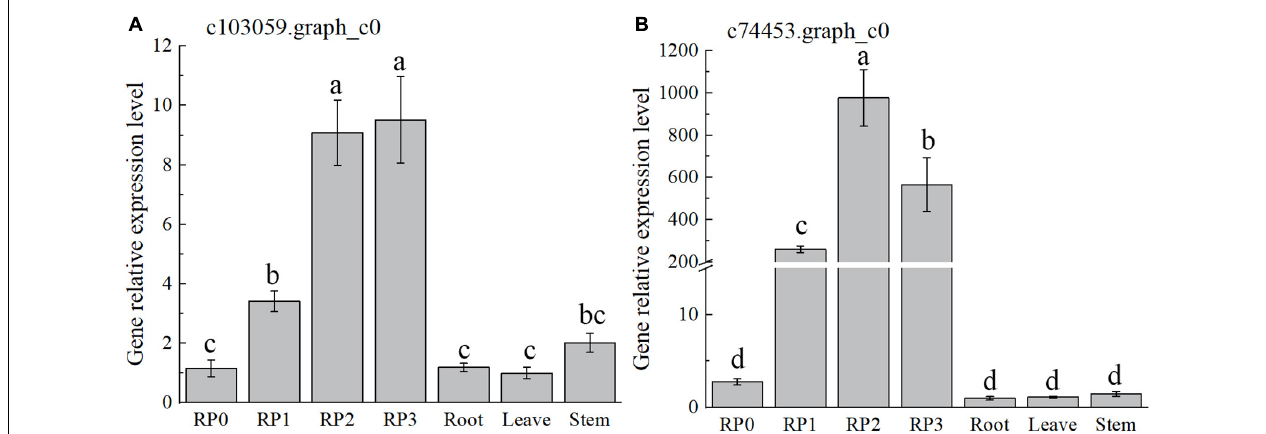
FIGURE 5 | Expression characteristics of two selected WRKY TFs in Freesia hybrida ‘Red Passion’ (RP). RP0, RP in the green bud stage; RP1, RP in the budding stage; RP2, RP in the early flowering stage; and RP3, RP in the flowering stage. The leaf was chosen as a calibrator sample of c103059.graph_c0 (A) . Root was chosen as a calibrator sample of c74453.graph_c0 (B) . Lowercase letters stand for the significance of difference at 0.05